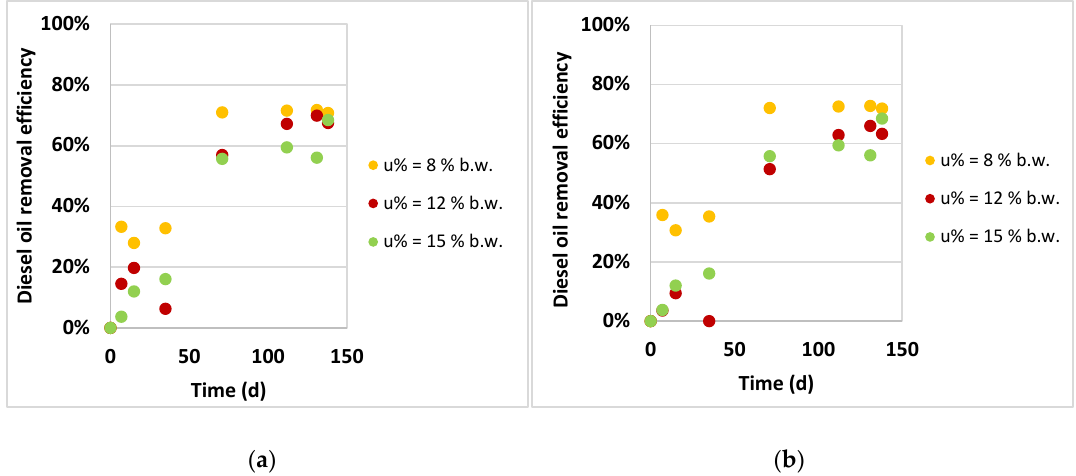
Figure 6. Diesel oil removal efficiency with C/N = 120: ( a ) C 0 = 70 g · kg −1 of soil; ( b ) C 0 was measured.